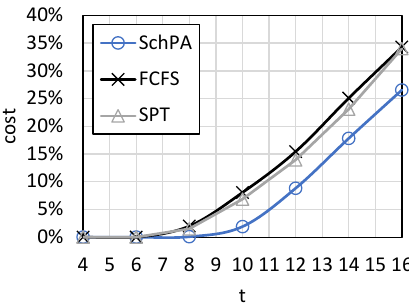
Figure 13. Comparison under varying t